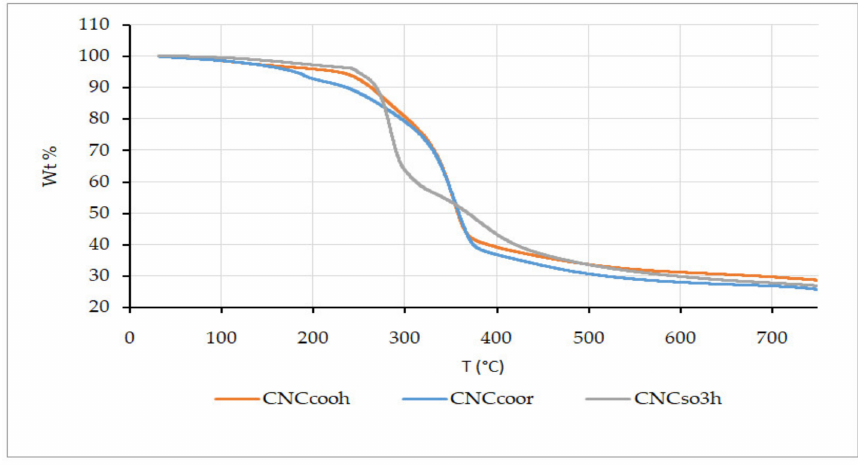
Figure 4. Thermal degradation pathways for the three